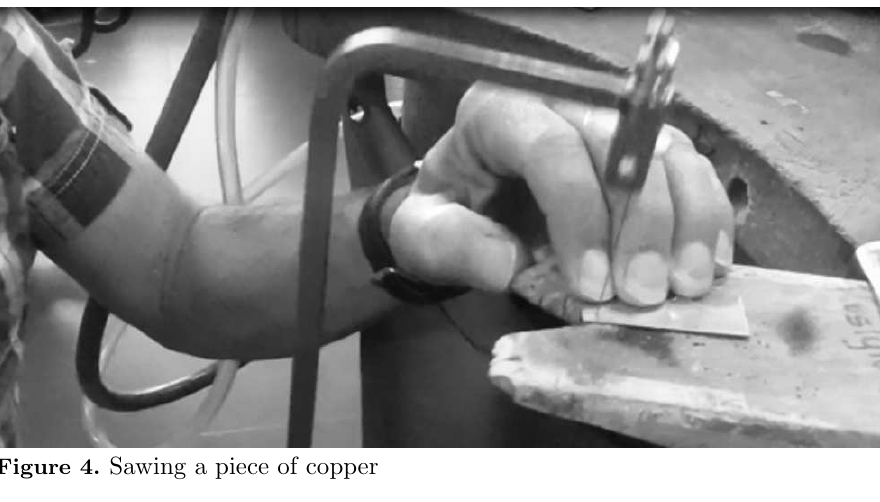
Figure 4. Sawing a piece of copper